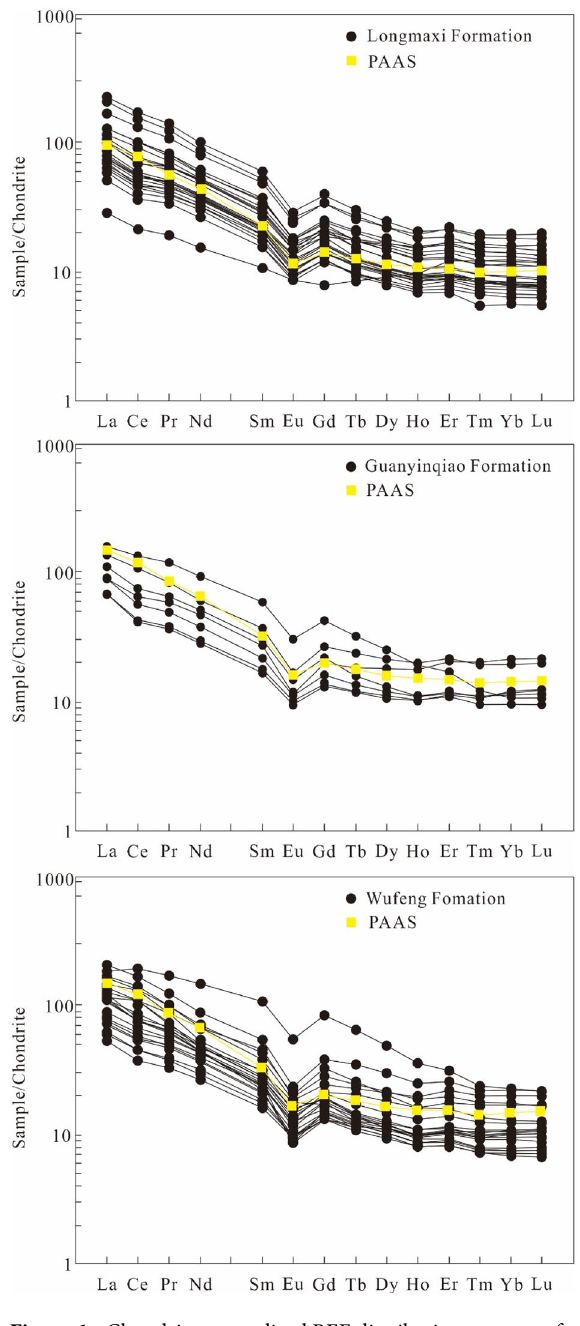
Figure 6. Chondrite-normalized REE distribution patterns of samples from the Wufeng-Longmaxi formations in the Xindi No. 2 well (normalization values are after Taylor and McLennan 64